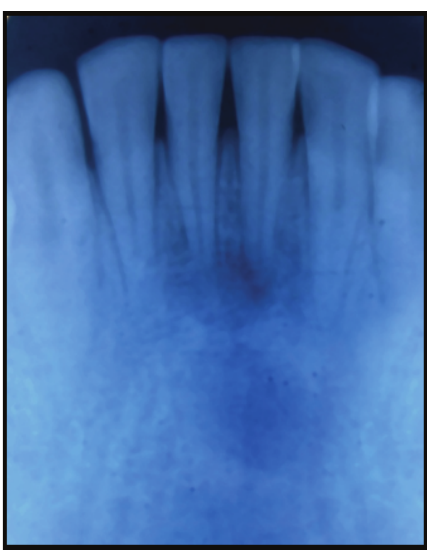
Figure 2: Pretreatment radiograph showing large periapical lesion involving Mandibular central incisors.